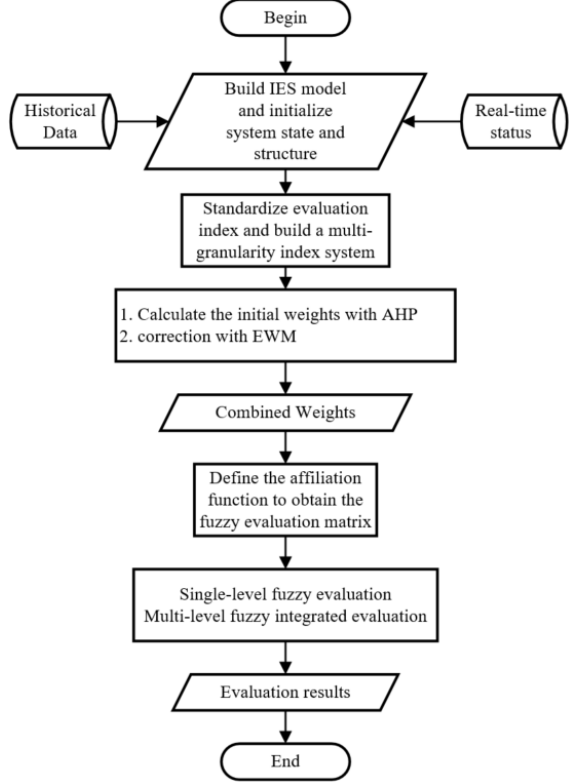
Figure 4. IES evaluation process based on combined methods.